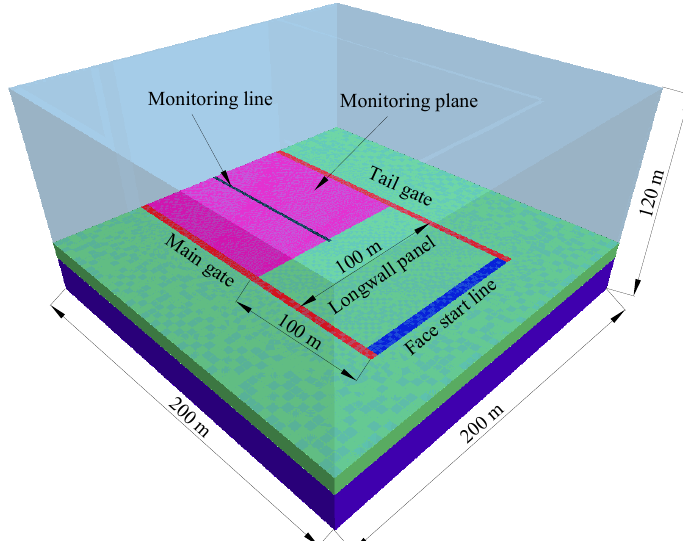
Figure 8. Numerical model layout.